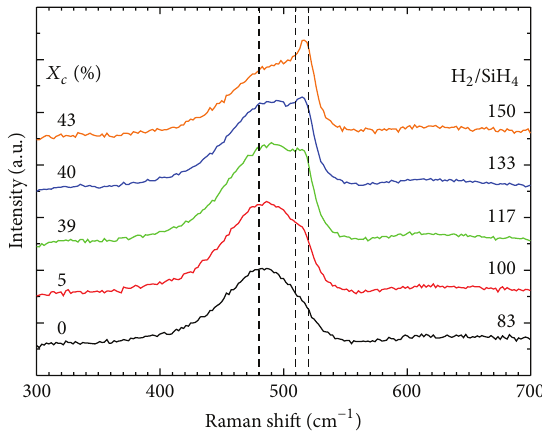
Figure 8: Dependence of the crystalline volume fraction on the H 2 /SiH 4 dilution for p- 𝜇 c-Si 1−𝑥 O 𝑥 :H films.